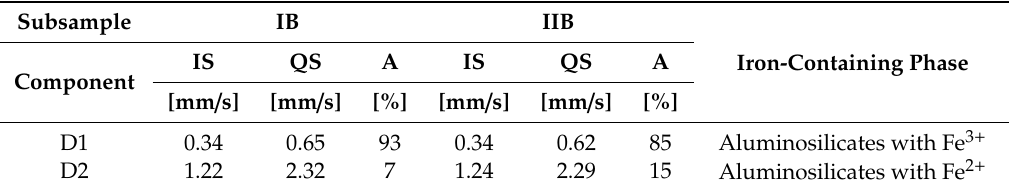
Table 4. Fitted Mössbauer parameters for spectra of samples IB and IIB, where doublet compounds have been described as D1 and D2. IS—isomer shift (with reference to metallic iron), QS—quadrupole splitting, A—relative area fraction with respect to whole fitted spectrum.